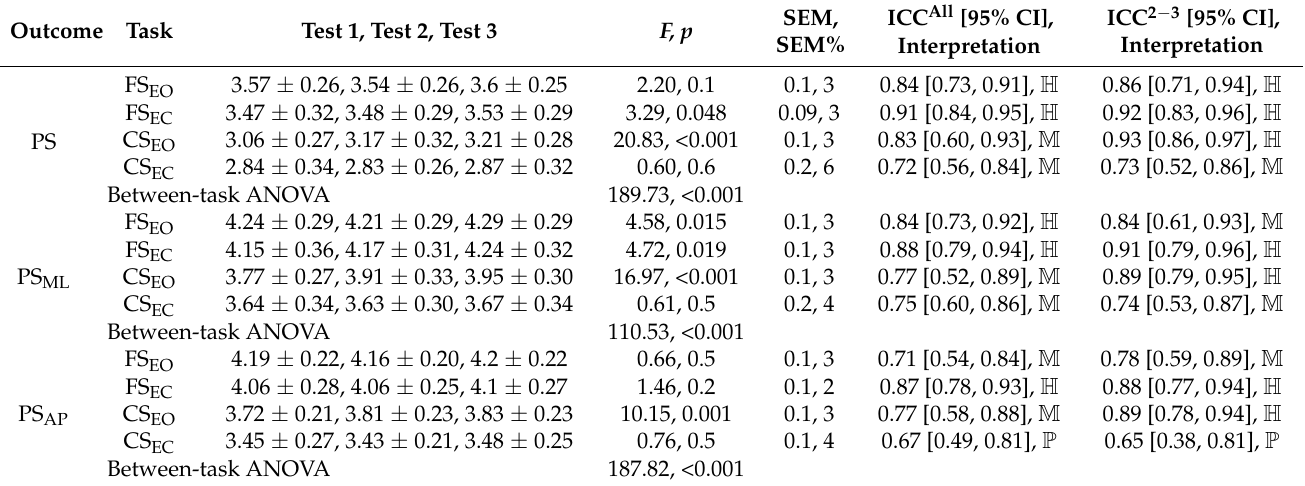
Table 5. Reliability, repetition effect, and between-task comparisons of the postural stability outcomes obtained from the Gait&Balance (G&B) application during the static balance tasks.